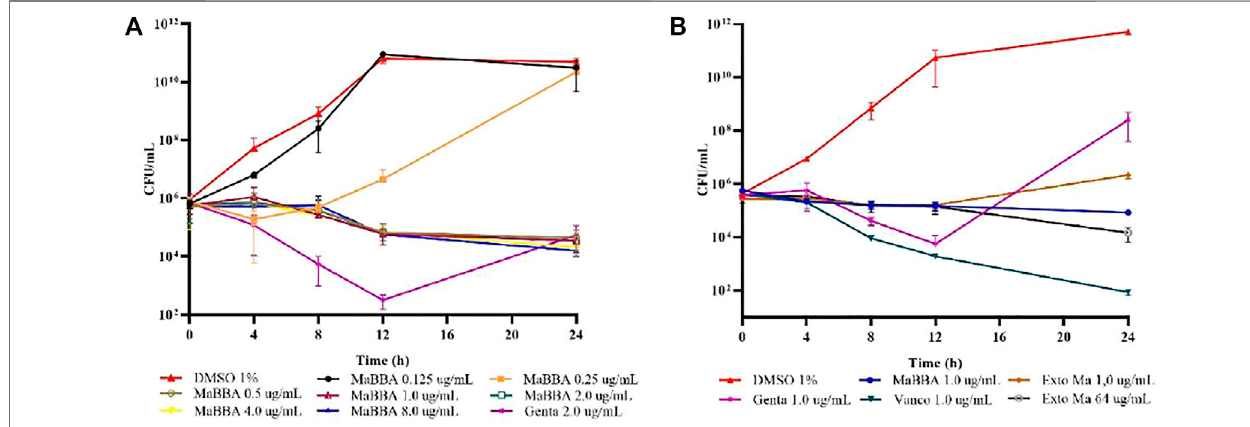
FIGURE3| Growthcurvesof S.aureus ATCC33591: (A) treatmentwithinhibitoryandsubinhibitoryconcentrationsofmammeaB/BA(MaBBA); (B) treatmentwith gentamicin (Genta), vancomycin (Vanco), MaBBA at a concentration of 1 μ g/ml and ethanolic extract of M. americana at a concentration of 1 and 64 μ g/ml. Each value represents the mean ± standard deviation of CFU/ml of